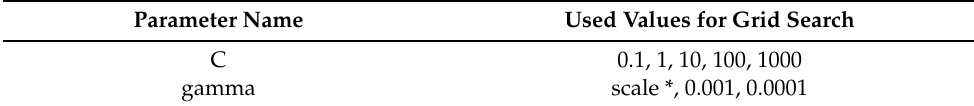
Table 4. Parameter search space for SVM classifier.